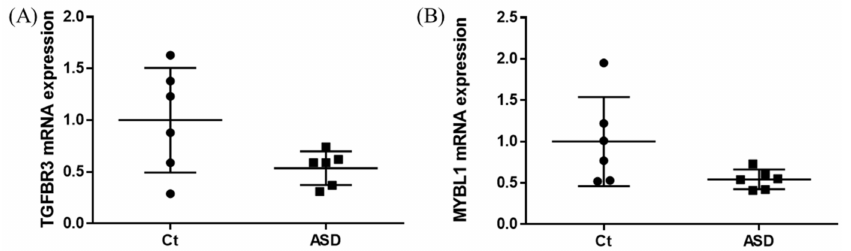
Figure 3. TGFBR3 and MYBL1 mRNA expression in the discovery cohort. The y -axis represents the ratio of the relative expression value of the control and ASD subjects for TGFBR3 ( A ) and MYBL ( B ). Ct, controls; ASD, autism spectrum disorder.